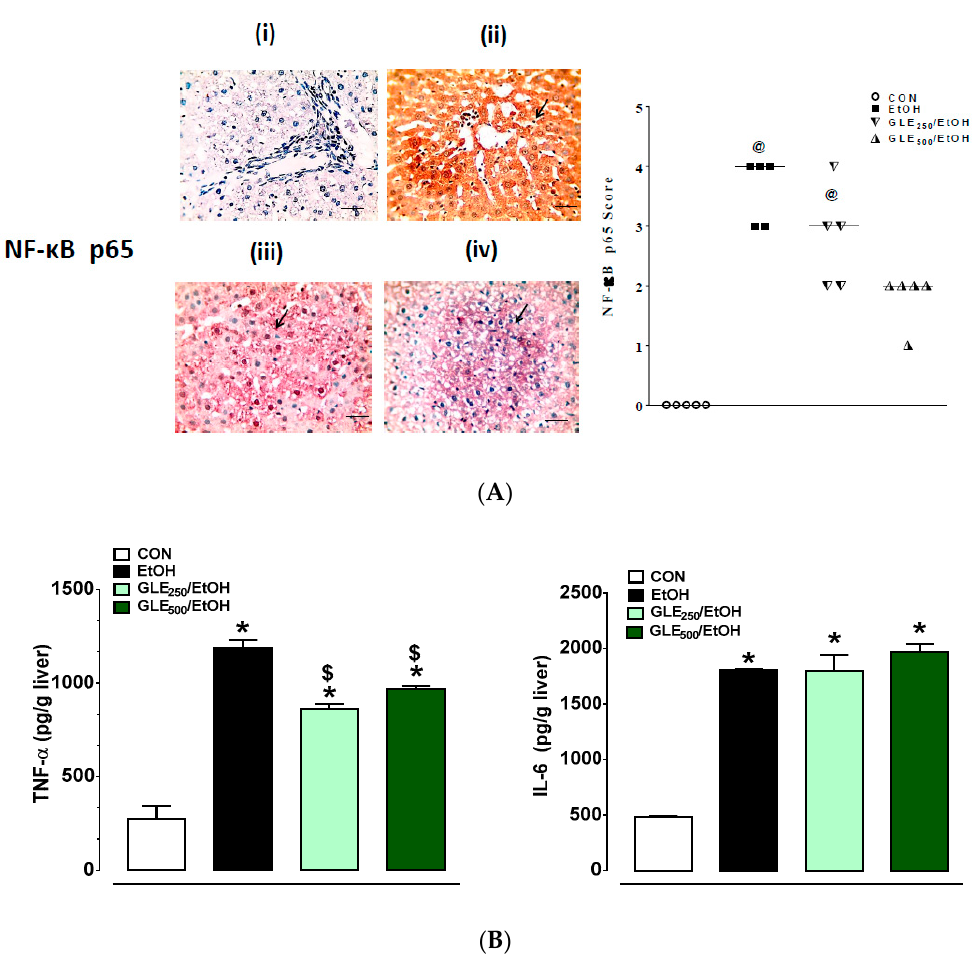
Figure 6. GLE effects on hepatic expression of NF- κ B p65 subunit and proinflammatory cytokines in EtOH-treated rats. Representative photomicrographs of immunohistochemical detection of NF- κ B p65 in livers from CON (i), EtOH (ii), GLE 250 /EtOH (iii), and GLE 500 /EtOH (iv) groups (left panel, A ), scatter-dot plot showing the score of NF- κ B p65 (median is indicated by a line) in the same groups (right panel, A ), bar graphs showing changes in TNF- α (left panel, B ) and IL-6 (right panel, B ). Data expressed as mean ± SEM in bar graphs (n = 5). @ p ≤ 0.05 compared with CON group (right panel, A), and *,$,# p ≤ 0.05 compared with CON, EtOH, GLE 250 /EtOH group, respectively ( B ). Statistical analysis was performed using Kruskal–Wallis followed by Dunn’s multiple-comparison test (right panel, A) or one-way ANOVA, followed by Tukey’s multiple-comparison test ( B ). CON: control, EtOH: ethanol, GLE: grape-leaf extract, NF- κ B: nuclear factor NF- κ B, TNF- α : tumor necrosis factor- α , IL-6: interleukin 6.